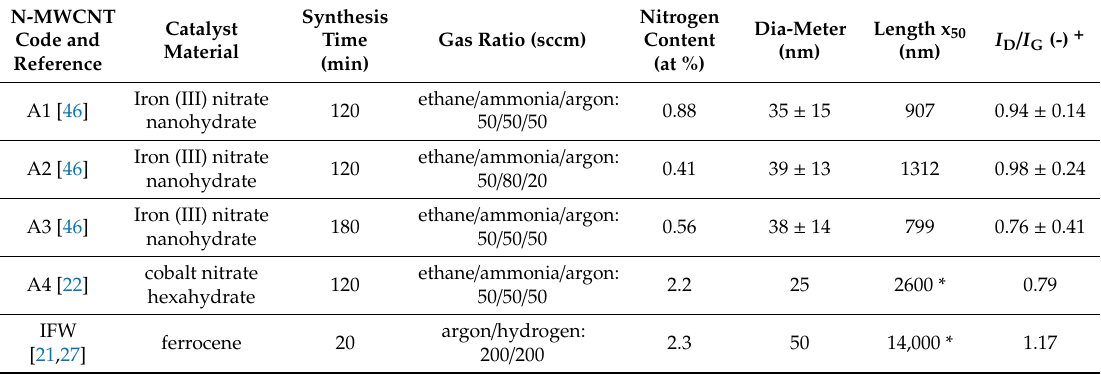
Table 1. Synthesis conditions and selected properties of N-doped multi-walled carbon